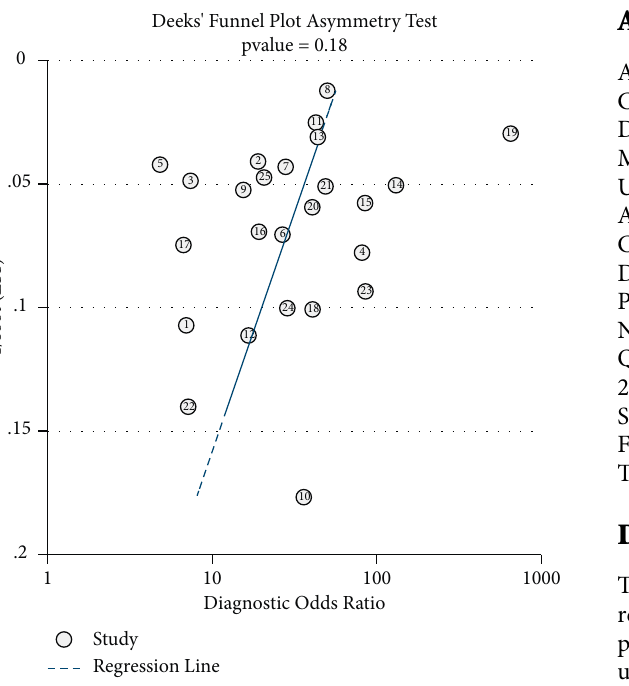
Figure 10: Results of Deeks’ funnel plot of asymmetry test for publication